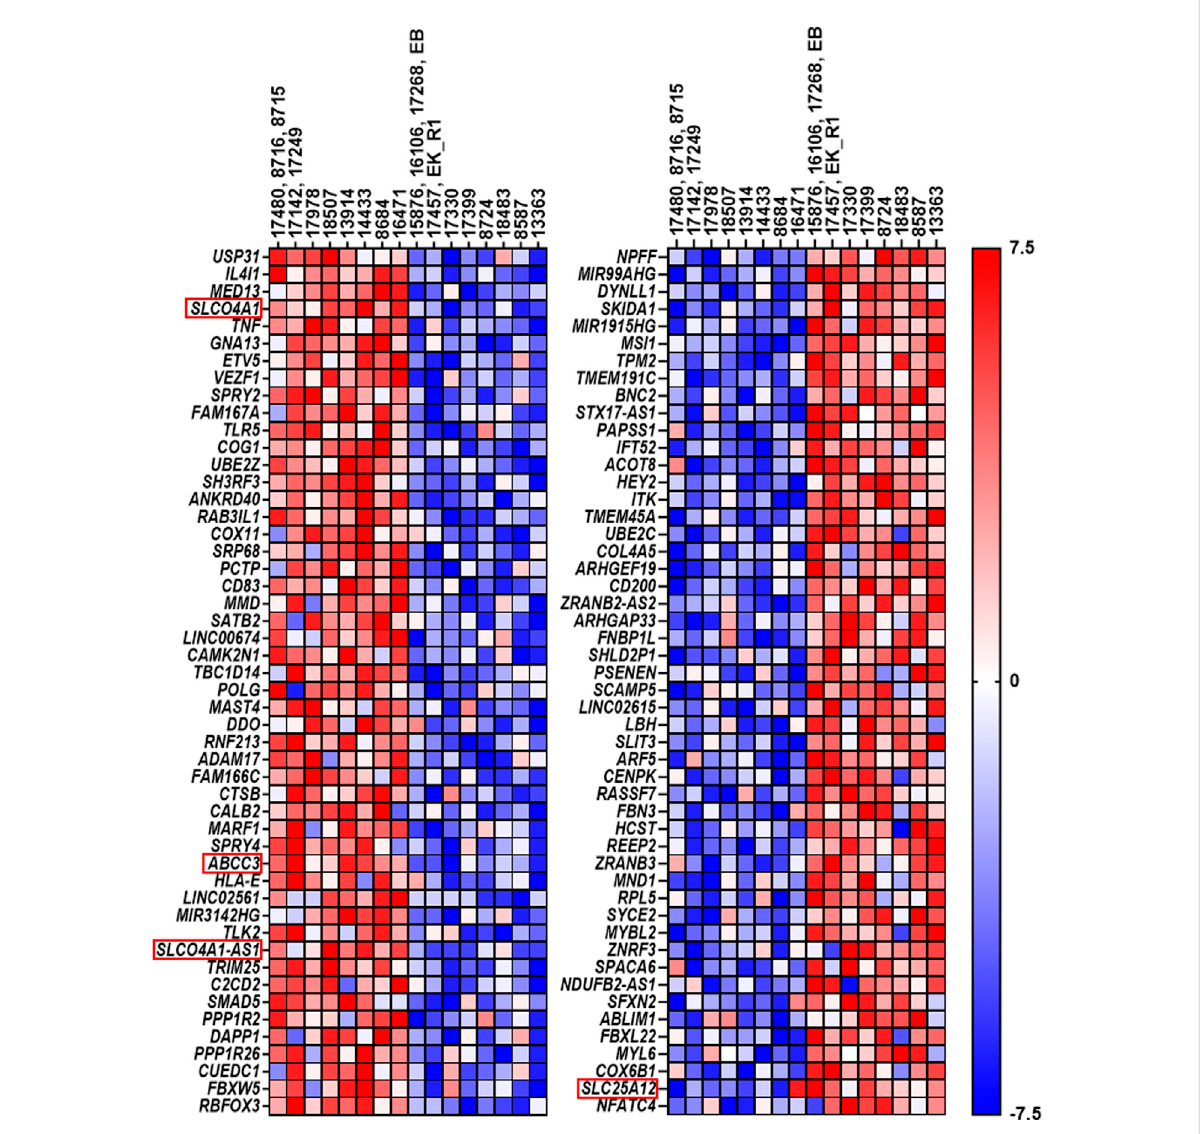
FIGURE 5 Top 50 genes resulting from gene set enrichment analysis. The left side displays the top 50 genes in cell lines expressing the highest SLCO4A1 level, while the right side shows the top 50 genes, which were upregulated in cell lines expressing the lowest SLCO4A1 level. Each of the two columns is annotated with their respective cell lines. Again, the cell lines on the left side of each column show the higher expressing ones, while the right side shows the cell lines, which express the lowest level of SLCO4A1. In cases where several cell lines were derived from the same patient,themeanvalueoftheRNAexpression fromthese cell lineswascalculated and used. Geneexpression isnormalizedfor eachrow; where red indicates higher expression while blue indicates the lower expression of the respective genes (ranked from − 7.5 to